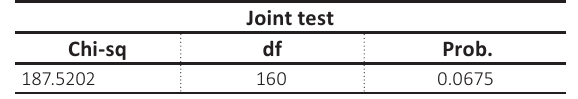
Table 9. Multicollinearity test